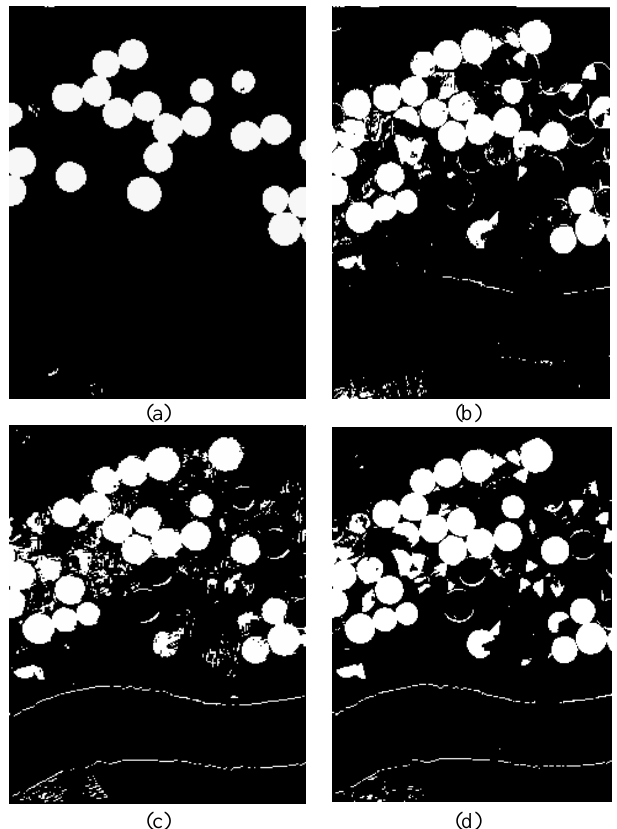
Fig. 5. The results of HCD methods for the USA dataset. The (a) MAD-SVM, (b) IR-MAD-SVM, (c) proposed method, and (d) Ground truth.